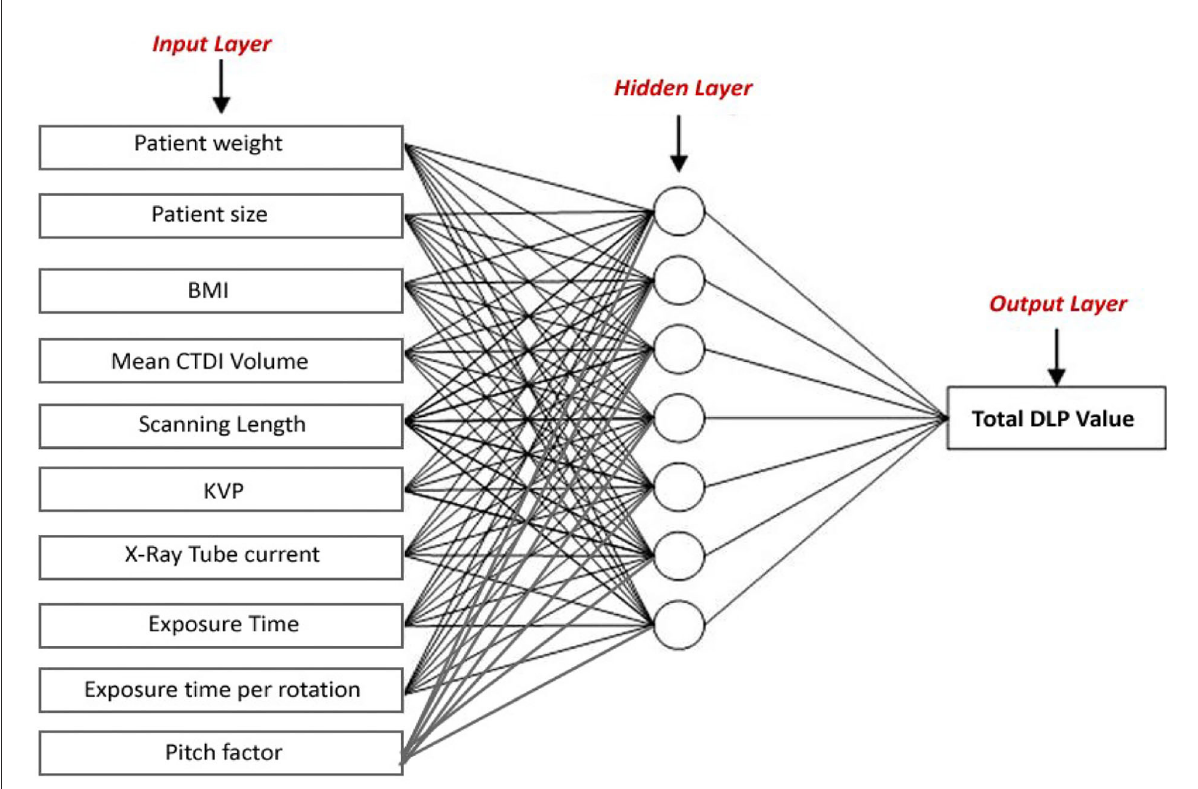
FIGURE1 The structure of the generated ANN